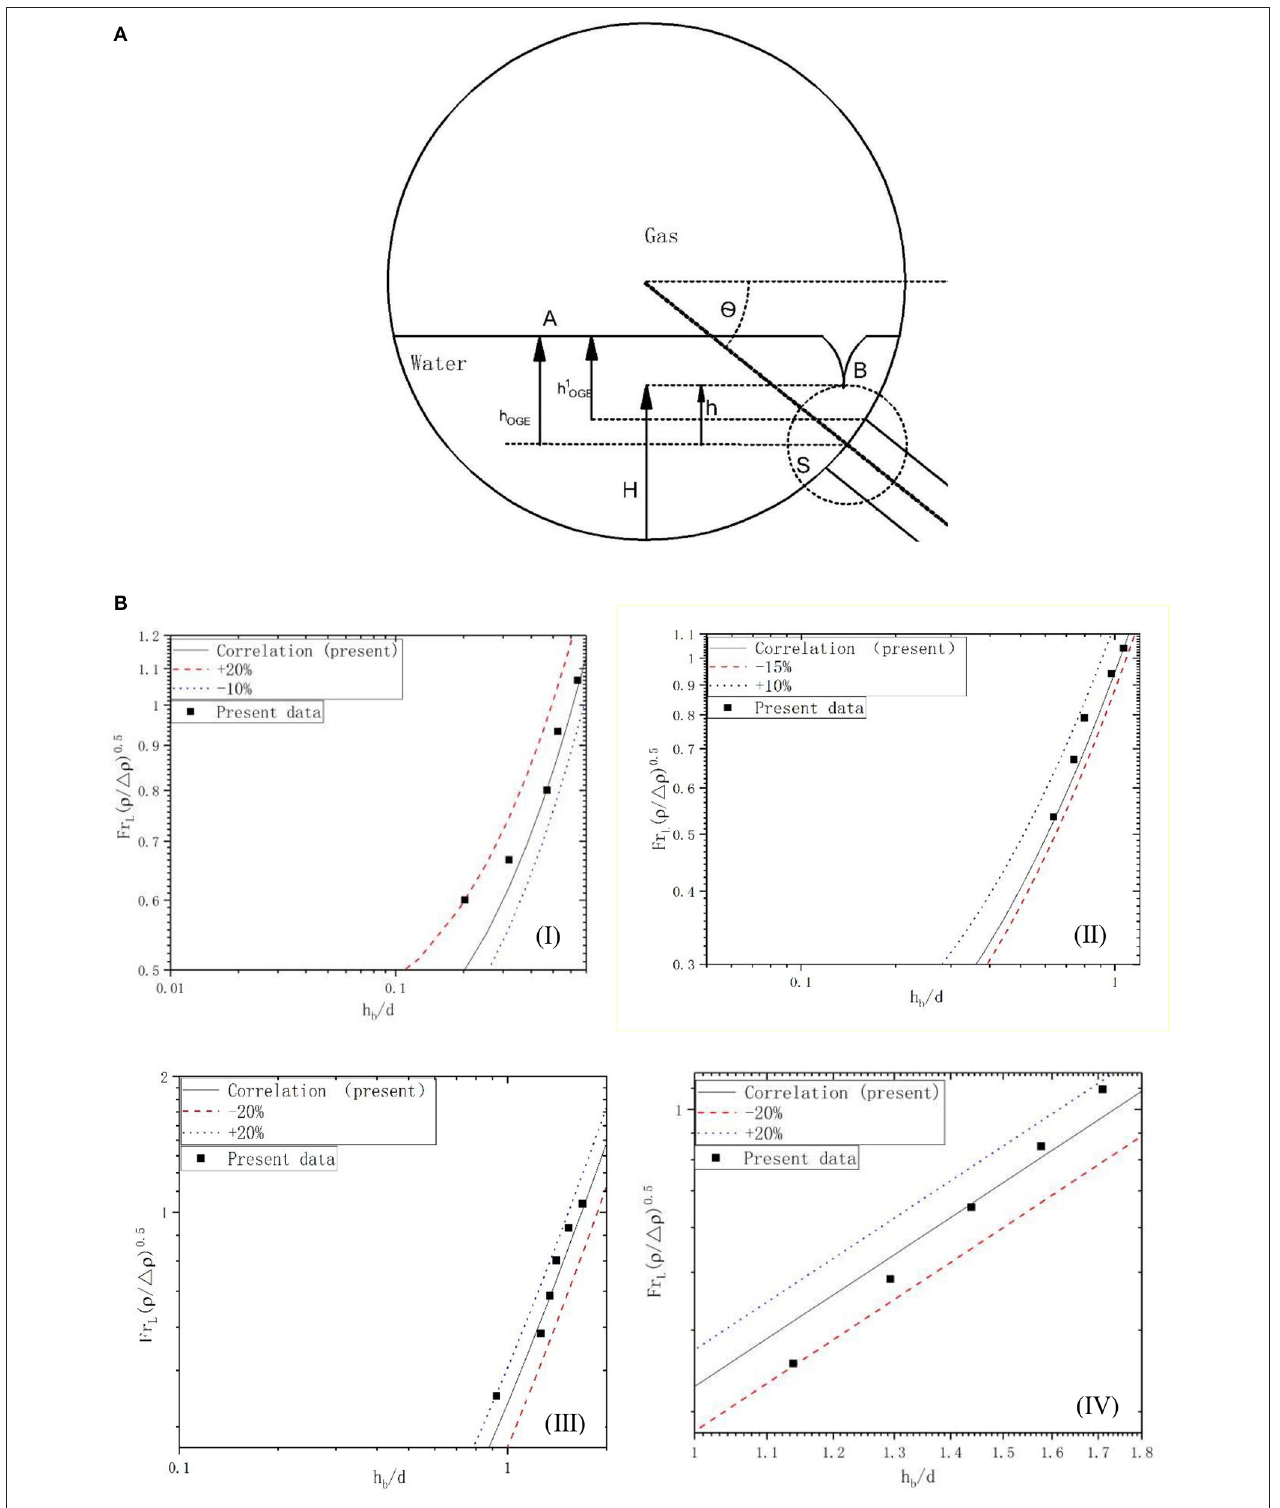
FIGURE 3 | Comparison and definition. (A) Schematics for the onset of gas entrainment. (B) Comparison of present OGE data with KfK and Lee, (I) θ = − 30 ◦ , (II) θ = − 45 ◦ , (III) θ = − 60 ◦ , (IV) θ = − 90 ◦ .